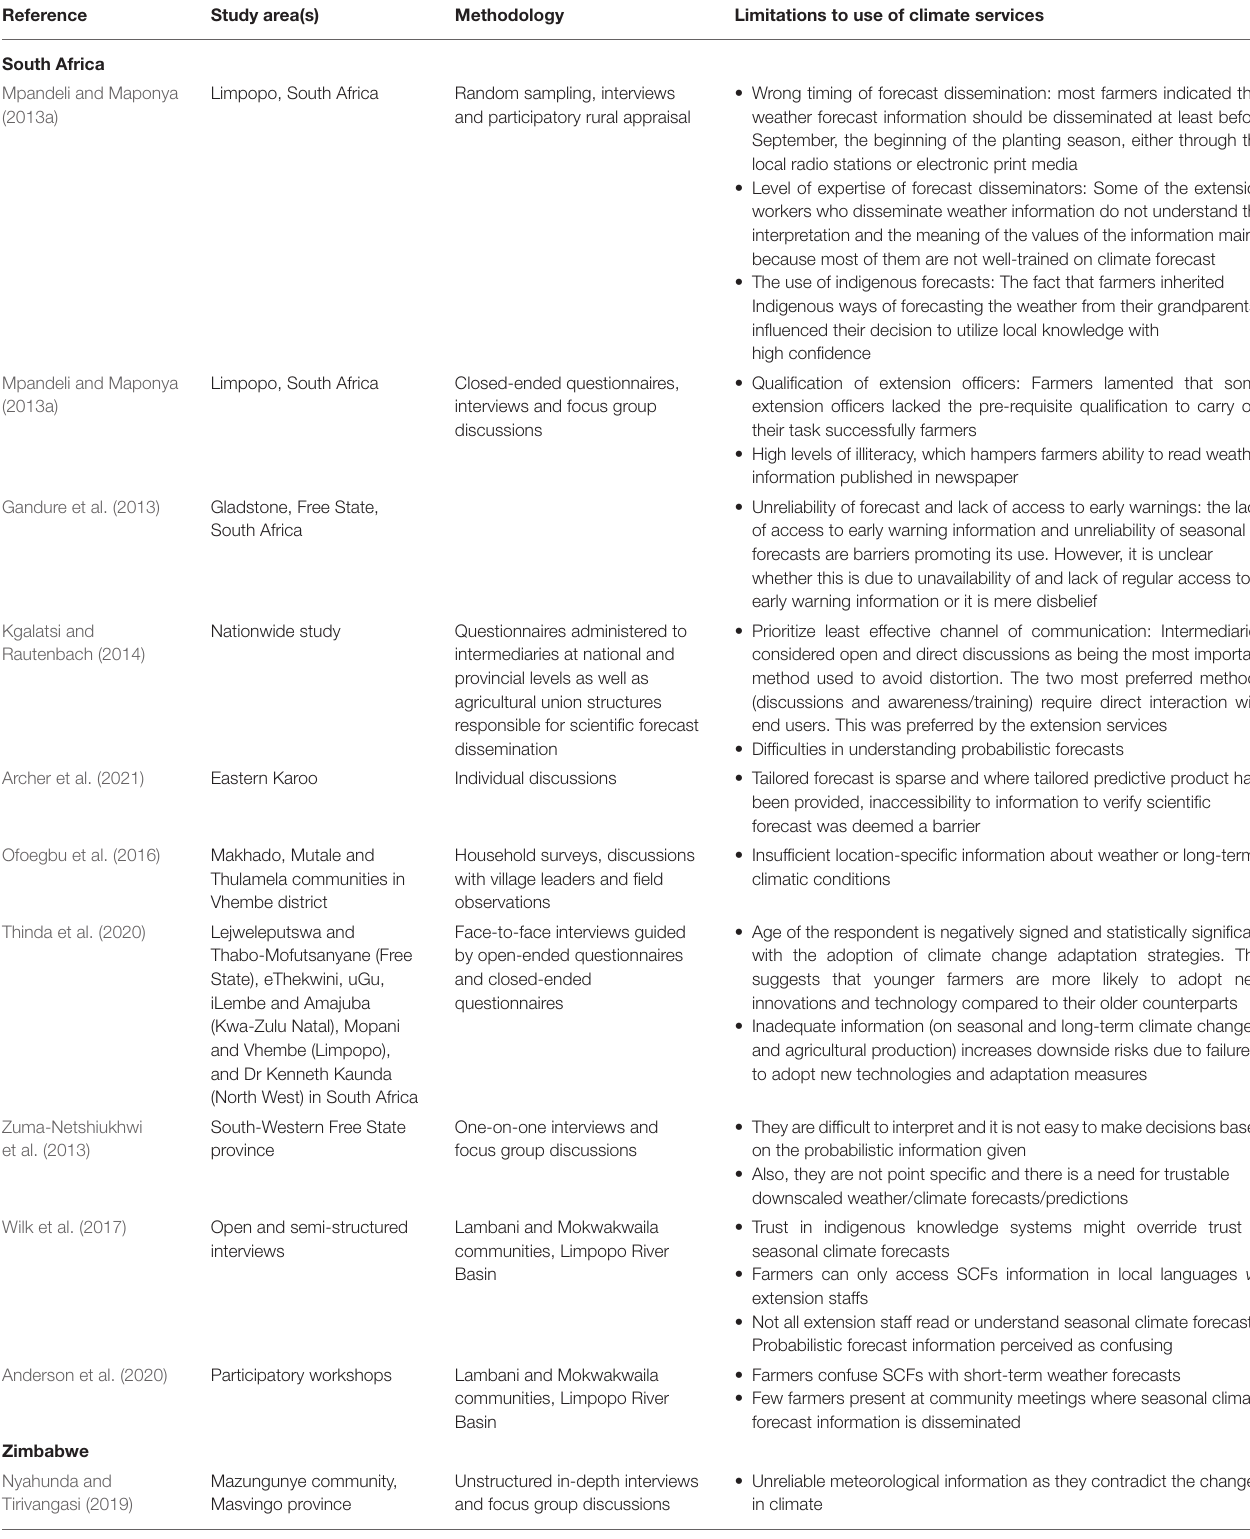
TABLE 1 | Factors undermining the use of climate services in South Africa and